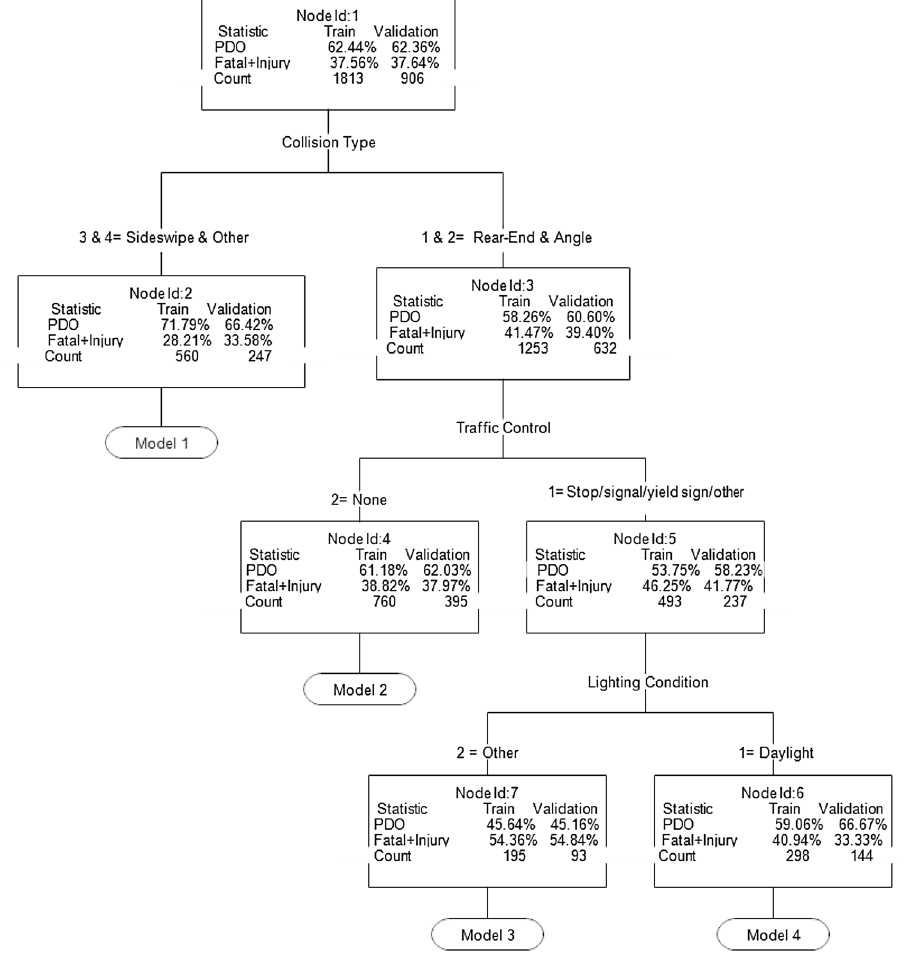
Fig. 1 Decision tree structure for the logistic-decision tree